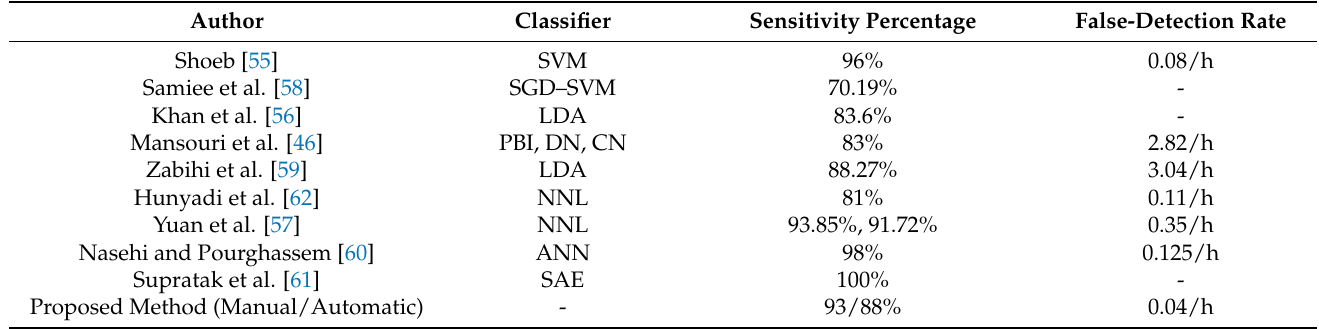
Table 6. Performance comparison of our proposed method with previous studies in the